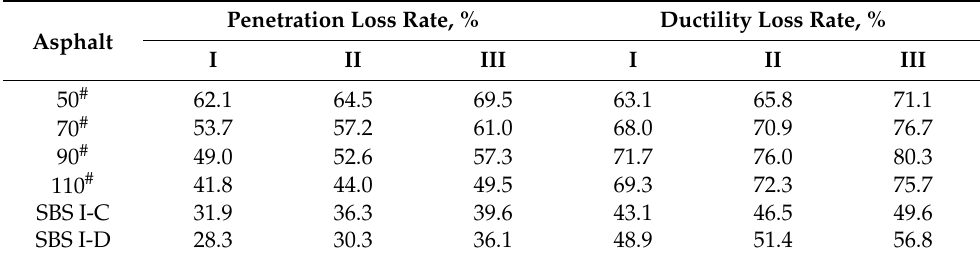
Table 5. The penetration loss rate and ductility loss rate of asphalt in different UV climate zones (taking the actual outdoor UV radiation for 6 months as the test